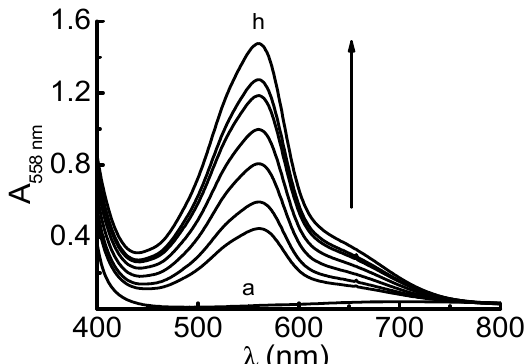
Figure 1. Absorption spectra of: (a) = Cu(II) 5.0 × 10 − 4 M + ammonium acetate buffer solution (pH = 7.0) 0.8 M + BCA 1.5 × 10 − 3 M; (b to h) = (a) + Ascorbic acid (0.71; 1.06; 1.41; 2.11; 2.47; 2.82 and 3.17) × 10 − 2 mg·mL − 1 , respectively. Measurements using water as reference solution.